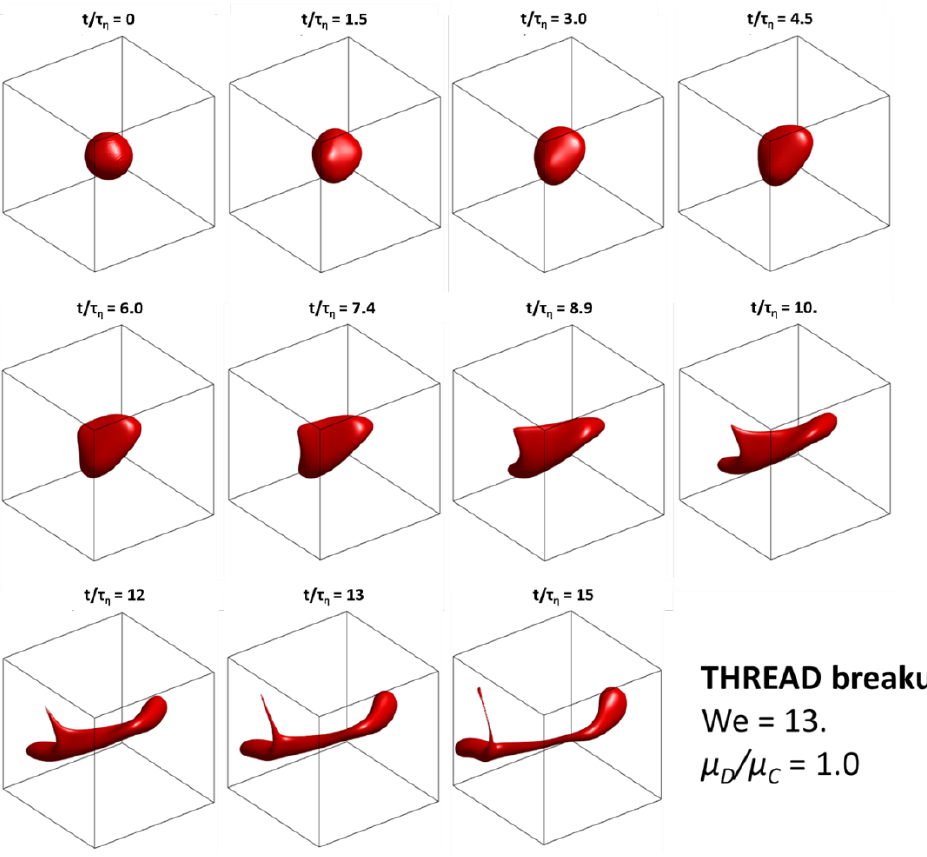
Figure 7. Breakup sequence for We = 7.0, µ D / µ C = 1. Illustrating the thread breakup morphology. (Iso-surfaces at α = 0.5).